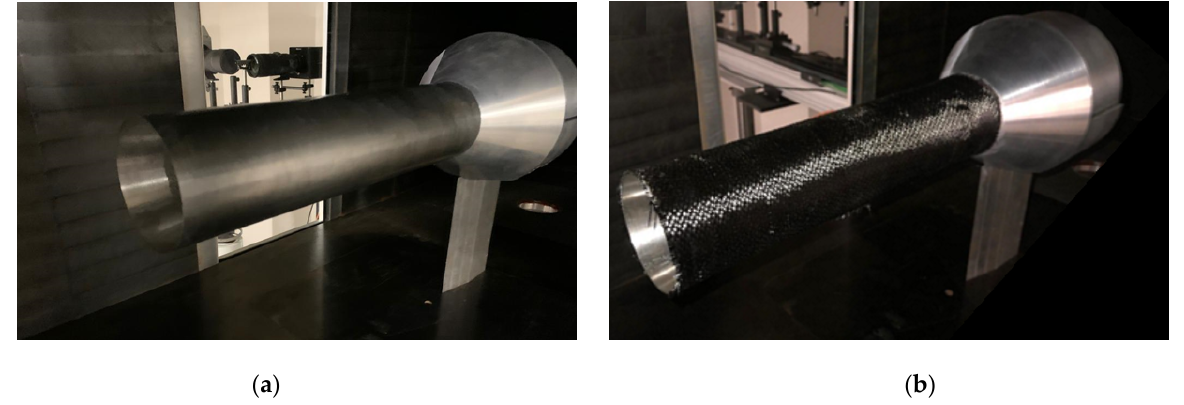
Figure 2. ( a ) Smooth surface and ( b ) rough hollow cylinder flare model mounted in the wind tunnel.